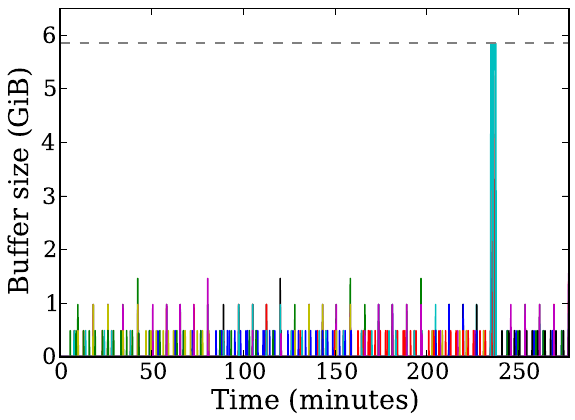
Figure 3. Buffer loading in a testing configuration of the MetUM. The buffer limit of 5.8GiB (6000MiB) is denoted by a dashed grey line.